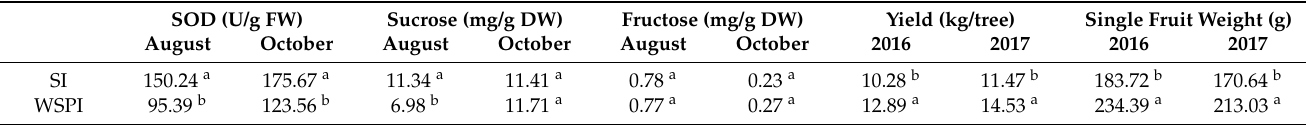
Table 2. Effects of water storage pit irrigation (WSPI) and surface irrigation (SI) on superoxide dismutase (SOD), sucrose, fructose, yield, and single fruit weight in 2016 and 2017. Different letters show significant differences ( p < 0.05).